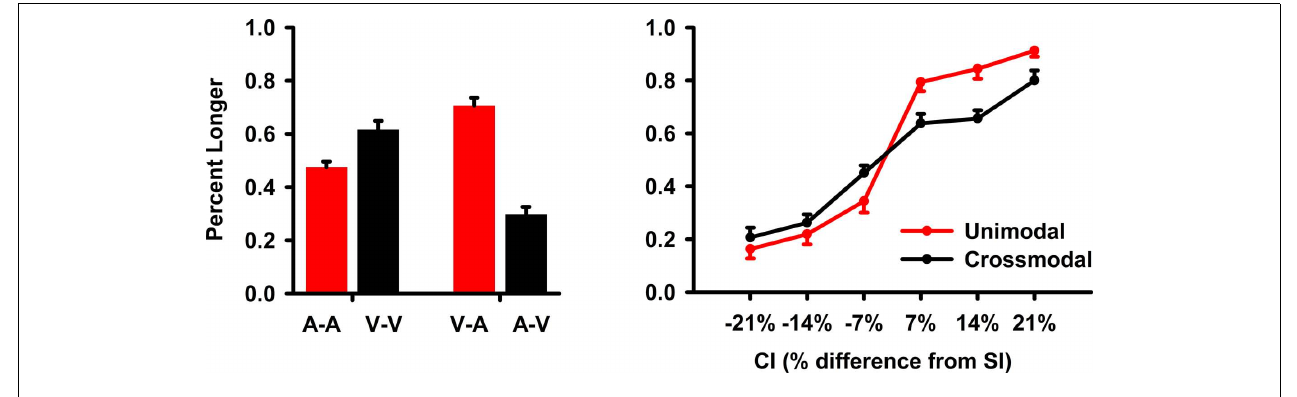
and crossmodal (V–A, A–V) condition.The right graph plots the mean percent longer responses for the unimodal and crossmodal conditions as a function of the CI duration. On the x axis, ± 7, 14, and 21 designate CIs that were 7, 14, and 21% shorter (negative values) or longer (positive values) than the